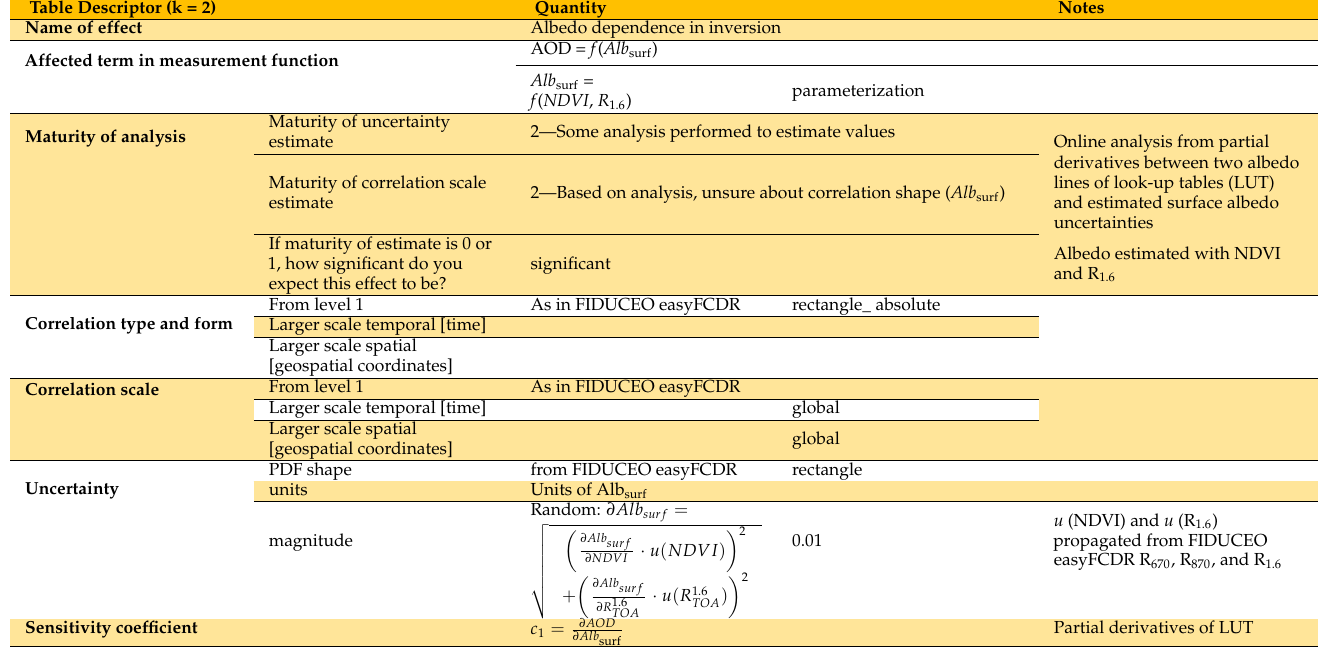
Table 2. Effects table for the albedo dependence in the inversion.